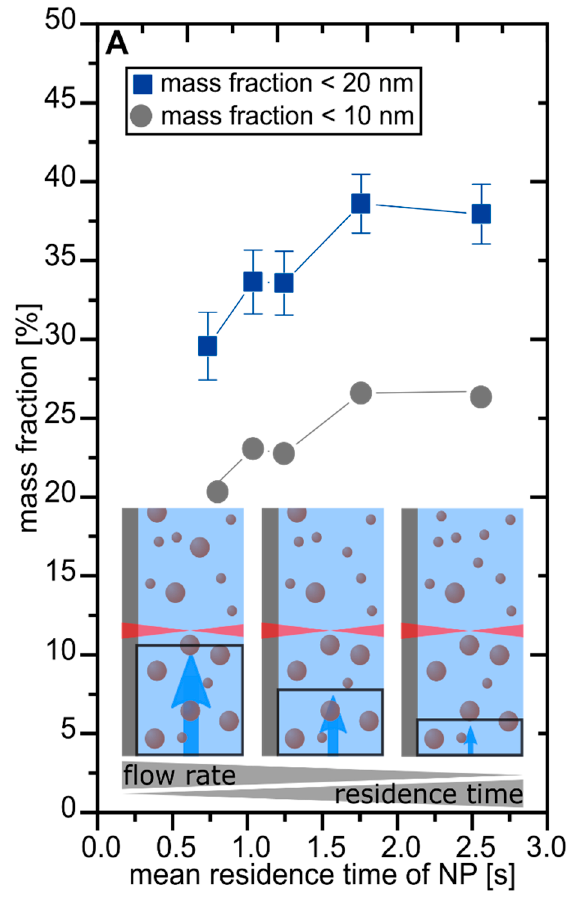
Figure 3. Variation of the mean residence time and the resulting mass fraction of particles < 10 nm (gray circles) and < 20 nm (blue squares); the sketches show how the irradiated volume decreases with increased residence time.